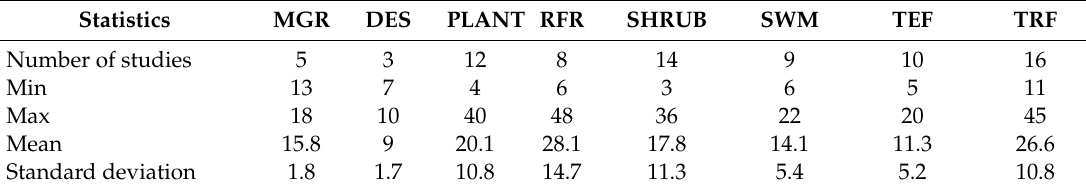
Table 4. Synopsis of the number of species (and dispersion measures) of sympatric snakes across habitats, on the basis of the selected studies. Abbreviations: MGR = mangrove; DES = desert; PLANT = plantation / agriculture; RFR = rainforest; SHRUB = shrublands / savannas / grasslands; SWM = swamps / marshlands / lakes; TEF = temperate forest; TRF = tropical forest. Statistics MGR DES PLANT RFR SHRUB